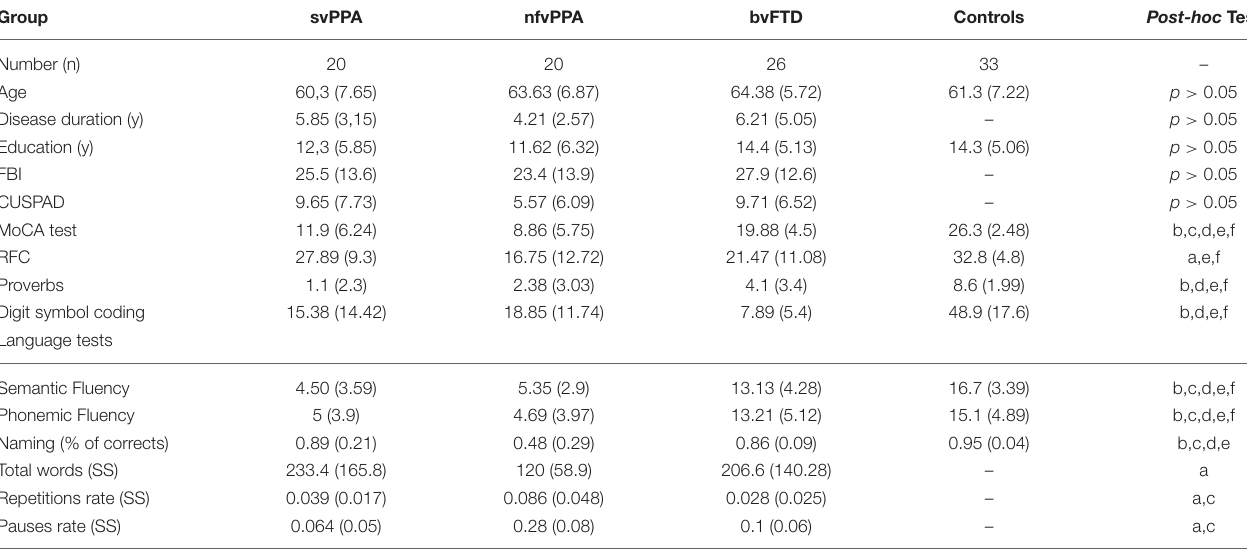
TABLE 1 | Demographic, clinical, and cognitive data from patients with controls, svPPA, nfvPPA, and bvFTD.